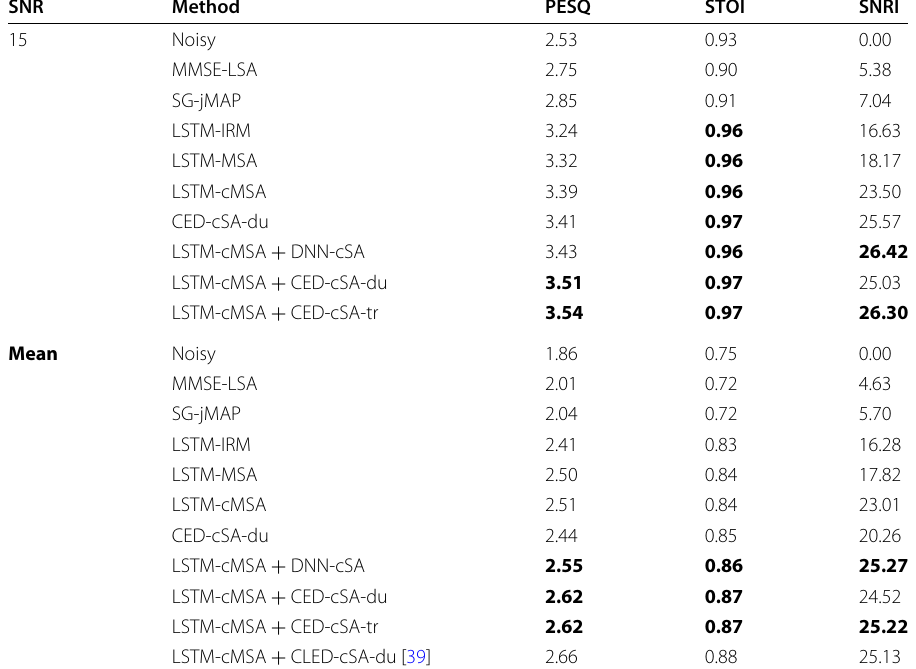
Table 2 Instrumental measures for baseline and proposed approaches averaged over seen noise types of the test set data. Note that the SNR conditions of − 5 and 15 dB are unseen during training, whereas the remaining SNRs have been seen. Best two approaches are in boldface , high-complexity reference LSTM-cMSA+CLED-cSA-du excluded ( Continued